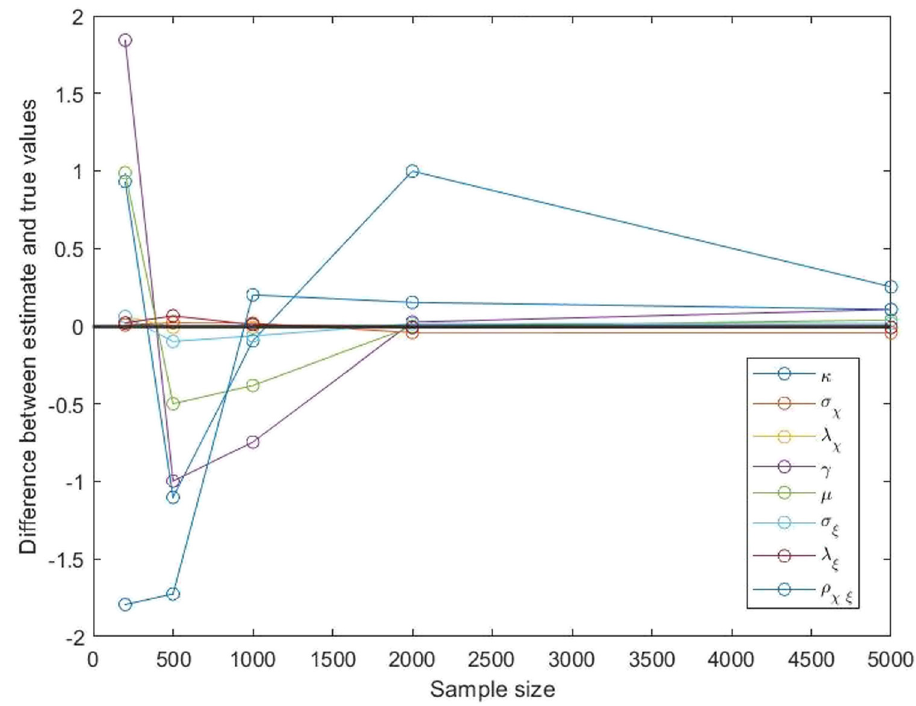
Figure 1: Parameter estimation error plots versus = n 500 , 1,000, 2,000, 5,000.